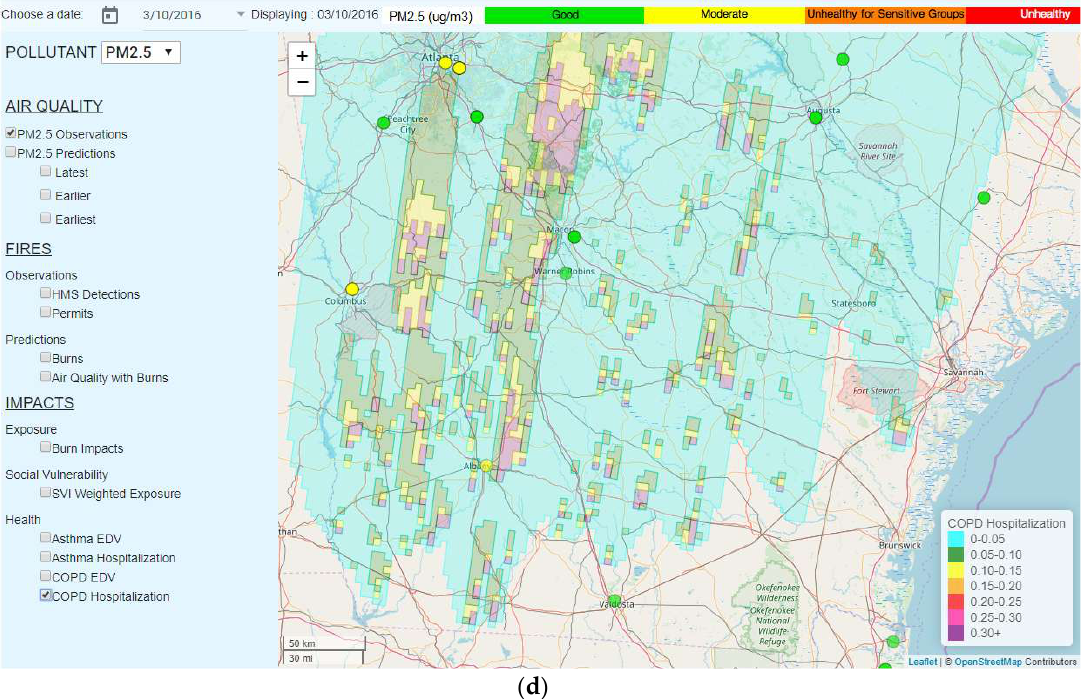
(cid:16) ∆ (cid:17) H ) for (a) EDV and (b) the hospitalization for ( a ) EDV and ( b ) the hospitalization H 0